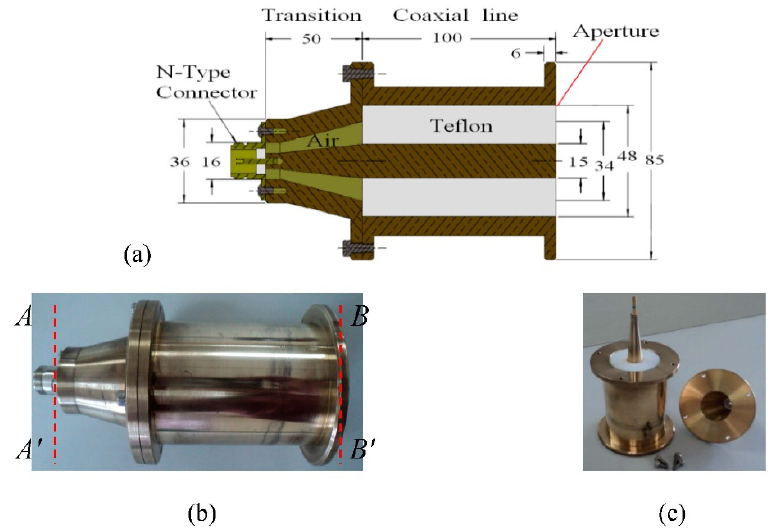
Figure 1. ( a ) Cross-sectional side view and dimensions (in mm) of the coaxial sensor. ( b ) Side view of the large coaxial sensor. ( c ) Internal configuration of the coaxial